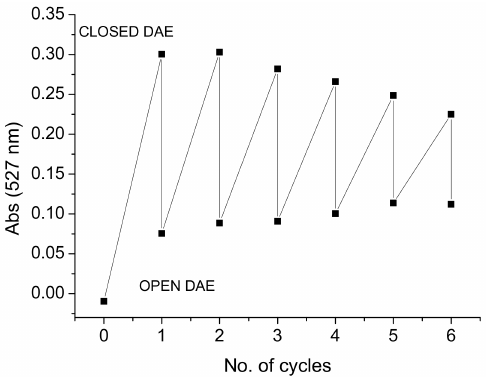
Figure 5. Changes at λ = 527 nm (specific for cyclic DAE form) during 6 repetitive “open-close” irradiations of DAE-NH-Py ( c = 1.0 × 10 − 4 M), for cyclisation 32 W, range 254–315 nm lamps; for de-cyclisation 32 W, range 400–700 nm lamps, done in MeOH/4.3% DMSO. Note the decrease in conversion rate in both closed DAE and open DAE form, proportional to the number of